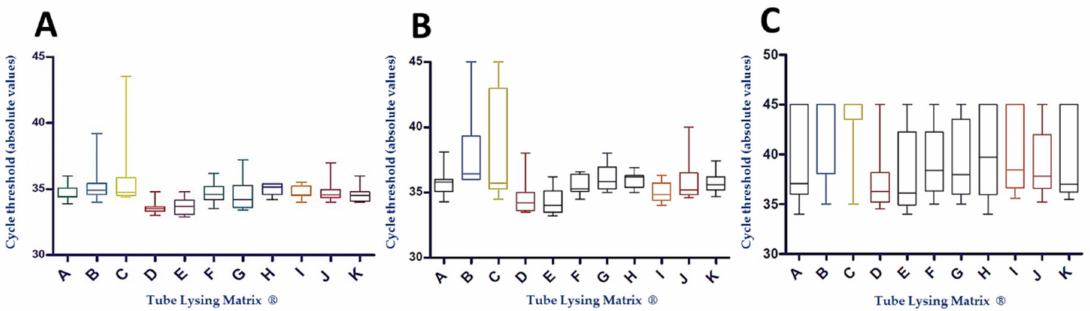
Figure 2. Distribution of the Ct results obtained according to the mechanical lysing matrix at the concentration of ( A ) 100 oocysts/mL, ( B ) 50 oocysts/mL, and ( C ) 20